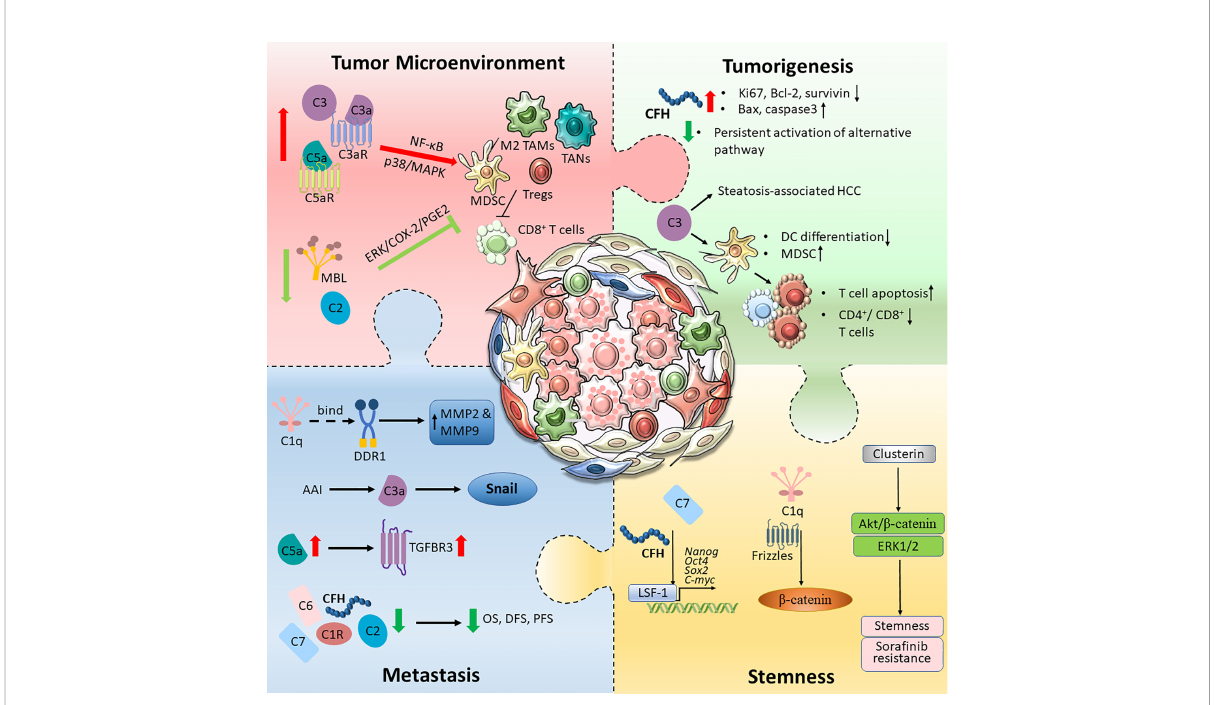
FIGURE 2 An overview of the complement activation in HCC tumour microenvironment. Tumour cells are capable of hijacking the immune system to cultivate a favourable TME. Different components of the complement pathway were found to be triggered and modi fi ed, forming an immunosuppressive environment. The schematic illustration summarised intricate interactions between tumour cells and the complement system, which promotes HCC tumourigenesis, metastatic and